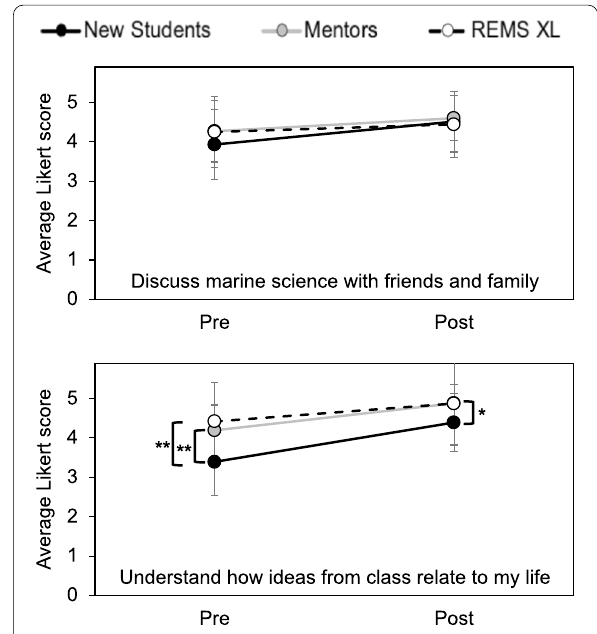
Fig. 23 Recognition: Comparing personal relevance of marine science among student groups. Average student responses (New Students ( N 105), Mentors ( N 26), REMS XL (12)) to REMS survey = = items (1 Not at all, 5 A great deal) regarding relevance of marine = = science concepts to personal life. Differences among student group scores were analyzed with Kruskal–Wallis tests with post hoc Dunn’s tests. * p < 0.05. ** p <